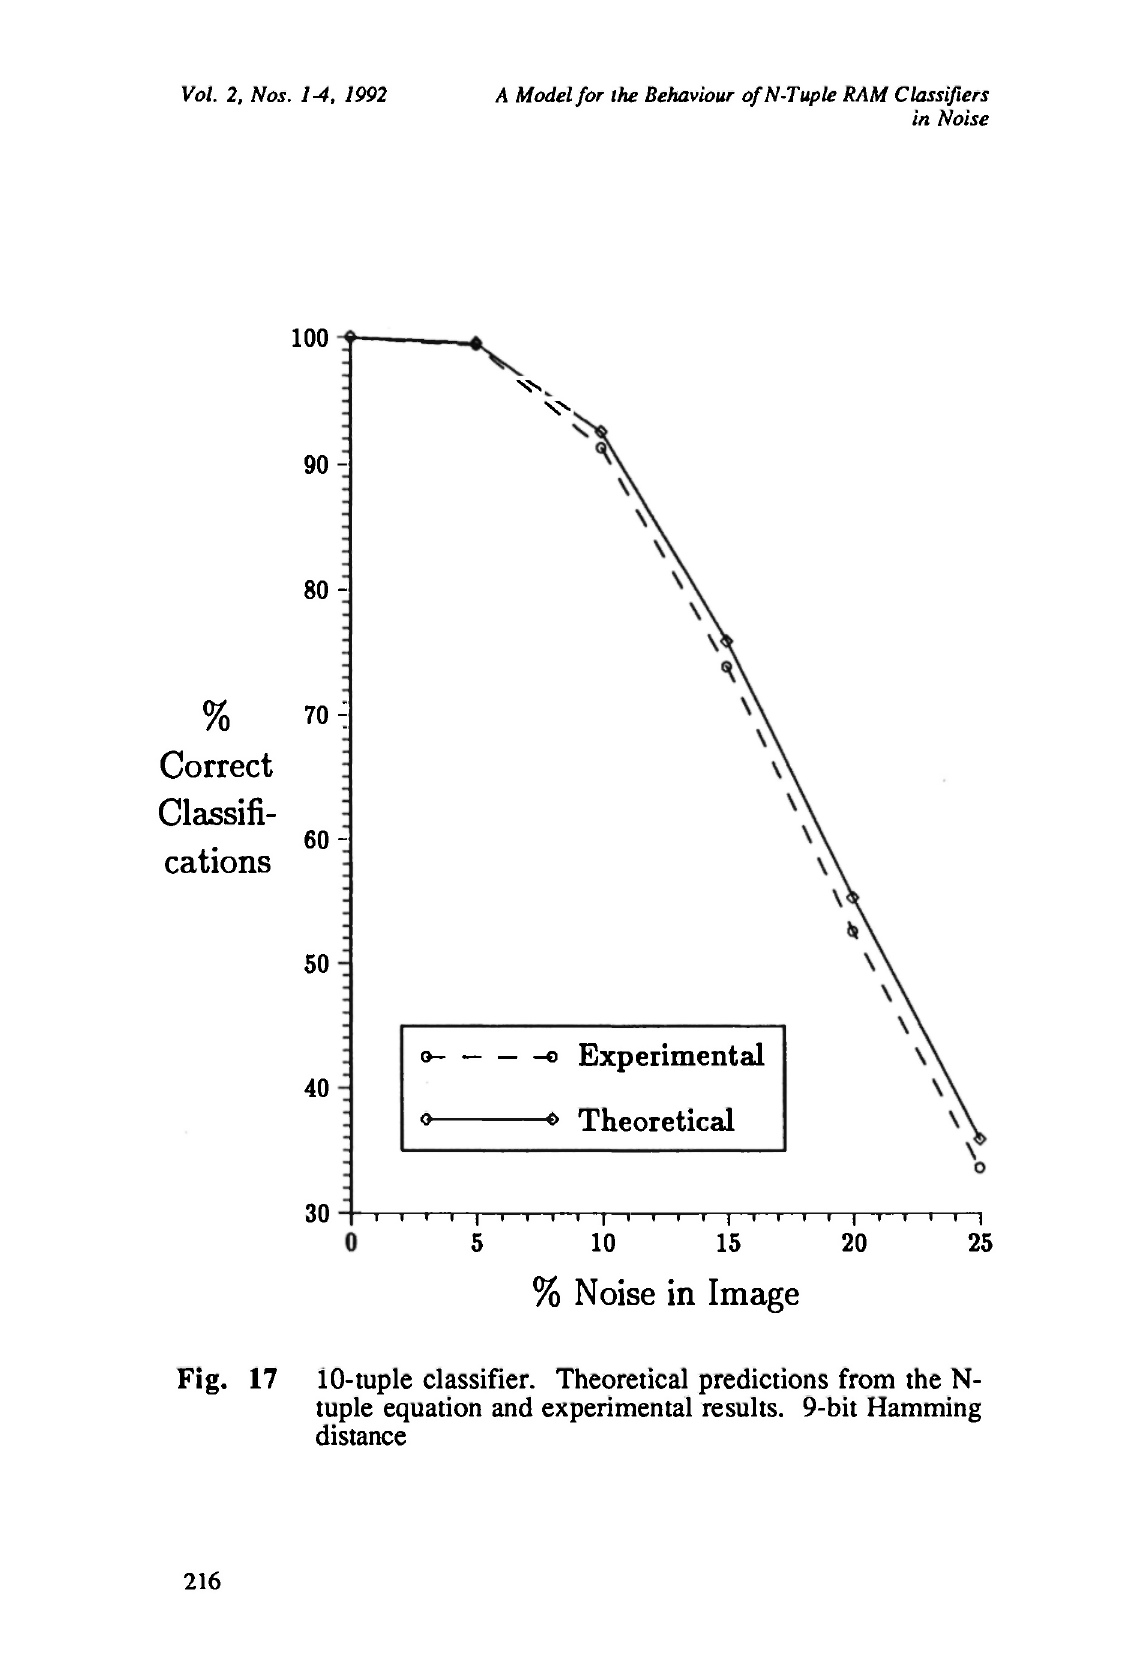
Fig. 17 10-tuple classifier. Theoretical predictions from the N- tuple equation and experimental results. 9-bit Hamming